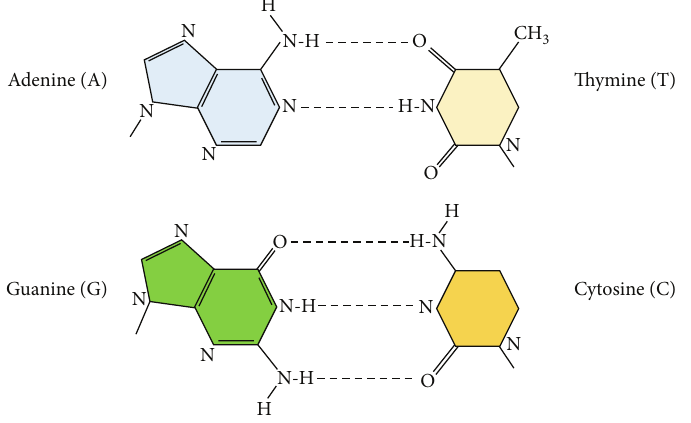
Figure 1: The structure of DNA strand.